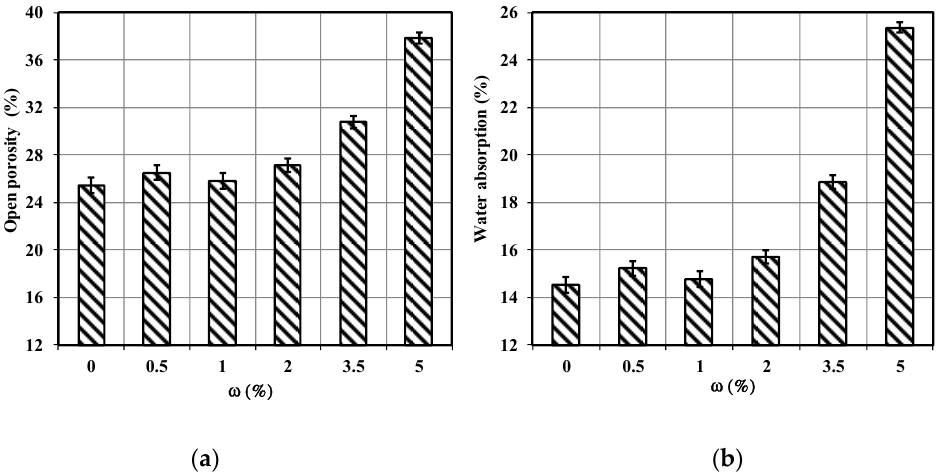
Figure 6. Effect of AF mass content at day 28 on open porosity ( a ) and on water absorption ( b ). Measurements uncertainties are respectively below 0.7% and 0.33%.